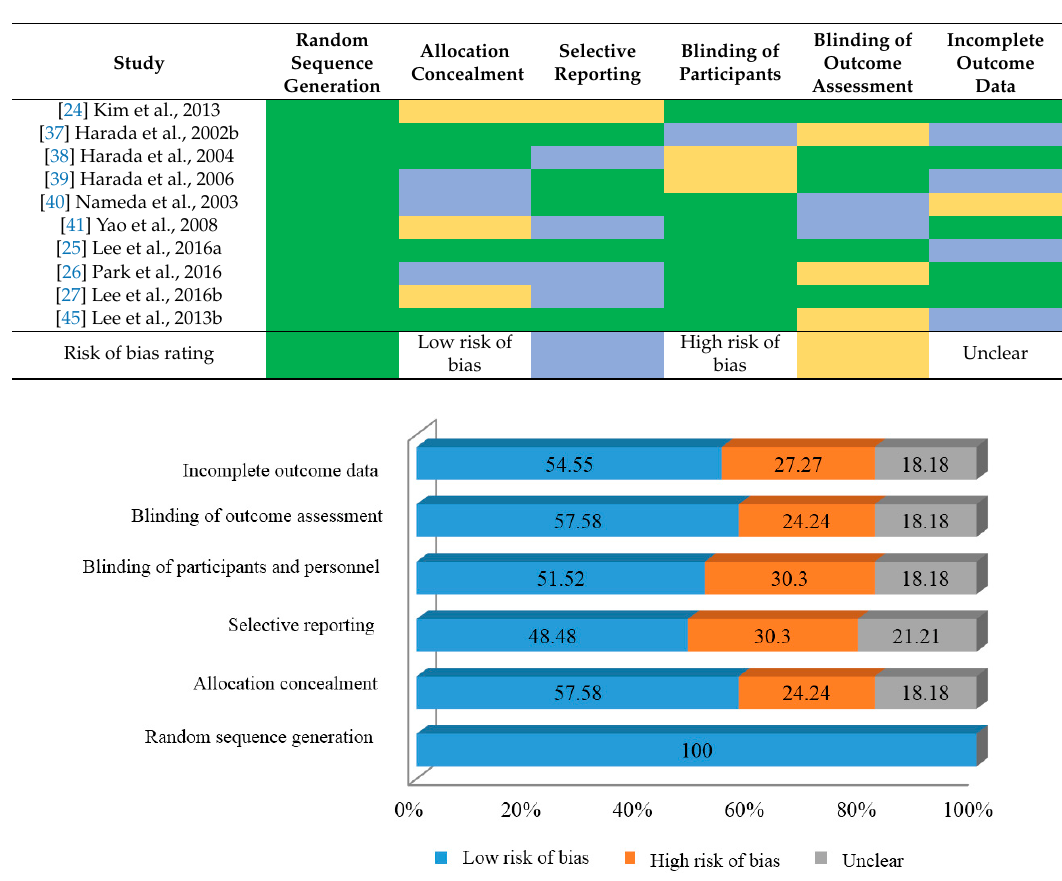
Figure 2. Risk of bias in individual studies graph.